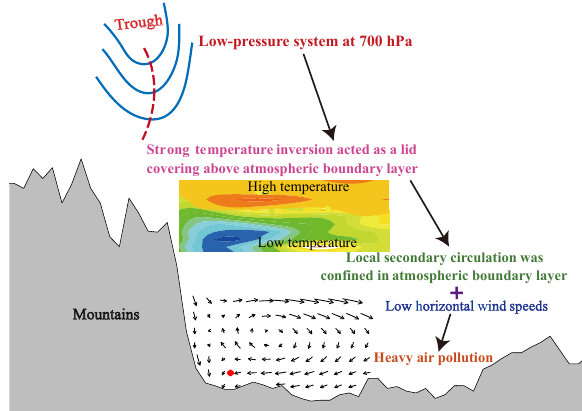
Figure 11. Schematic diagram of the mechanism of influence of a dry low-pressure system on winter heavy air pollution events in the urban